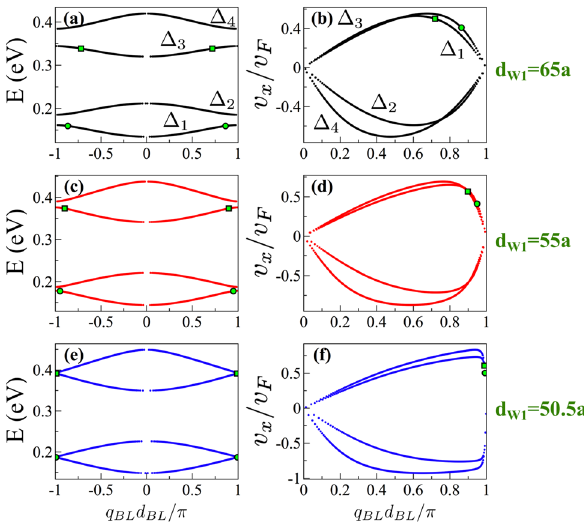
Figure 15. The same as Fig. 14, but here d W 1 is varied as indicated. The biperiodic superlattice parameters are: V 0 = 0.1 eV, d B = d W 2 = 50 a and θ = 45 ◦ . (cid:31) 1 , (cid:31) 2 , (cid:31) 3 and (cid:31) 4 represent the first, second, third and fourth electron energy minibands, respectively. The points and squares in color correspond to transparent states.